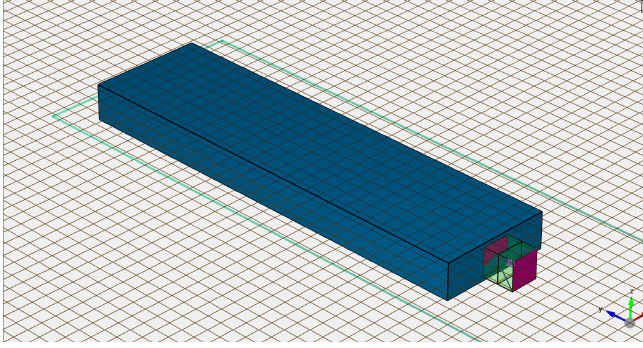
Figure 1. The rectangular cuboid object with a source.